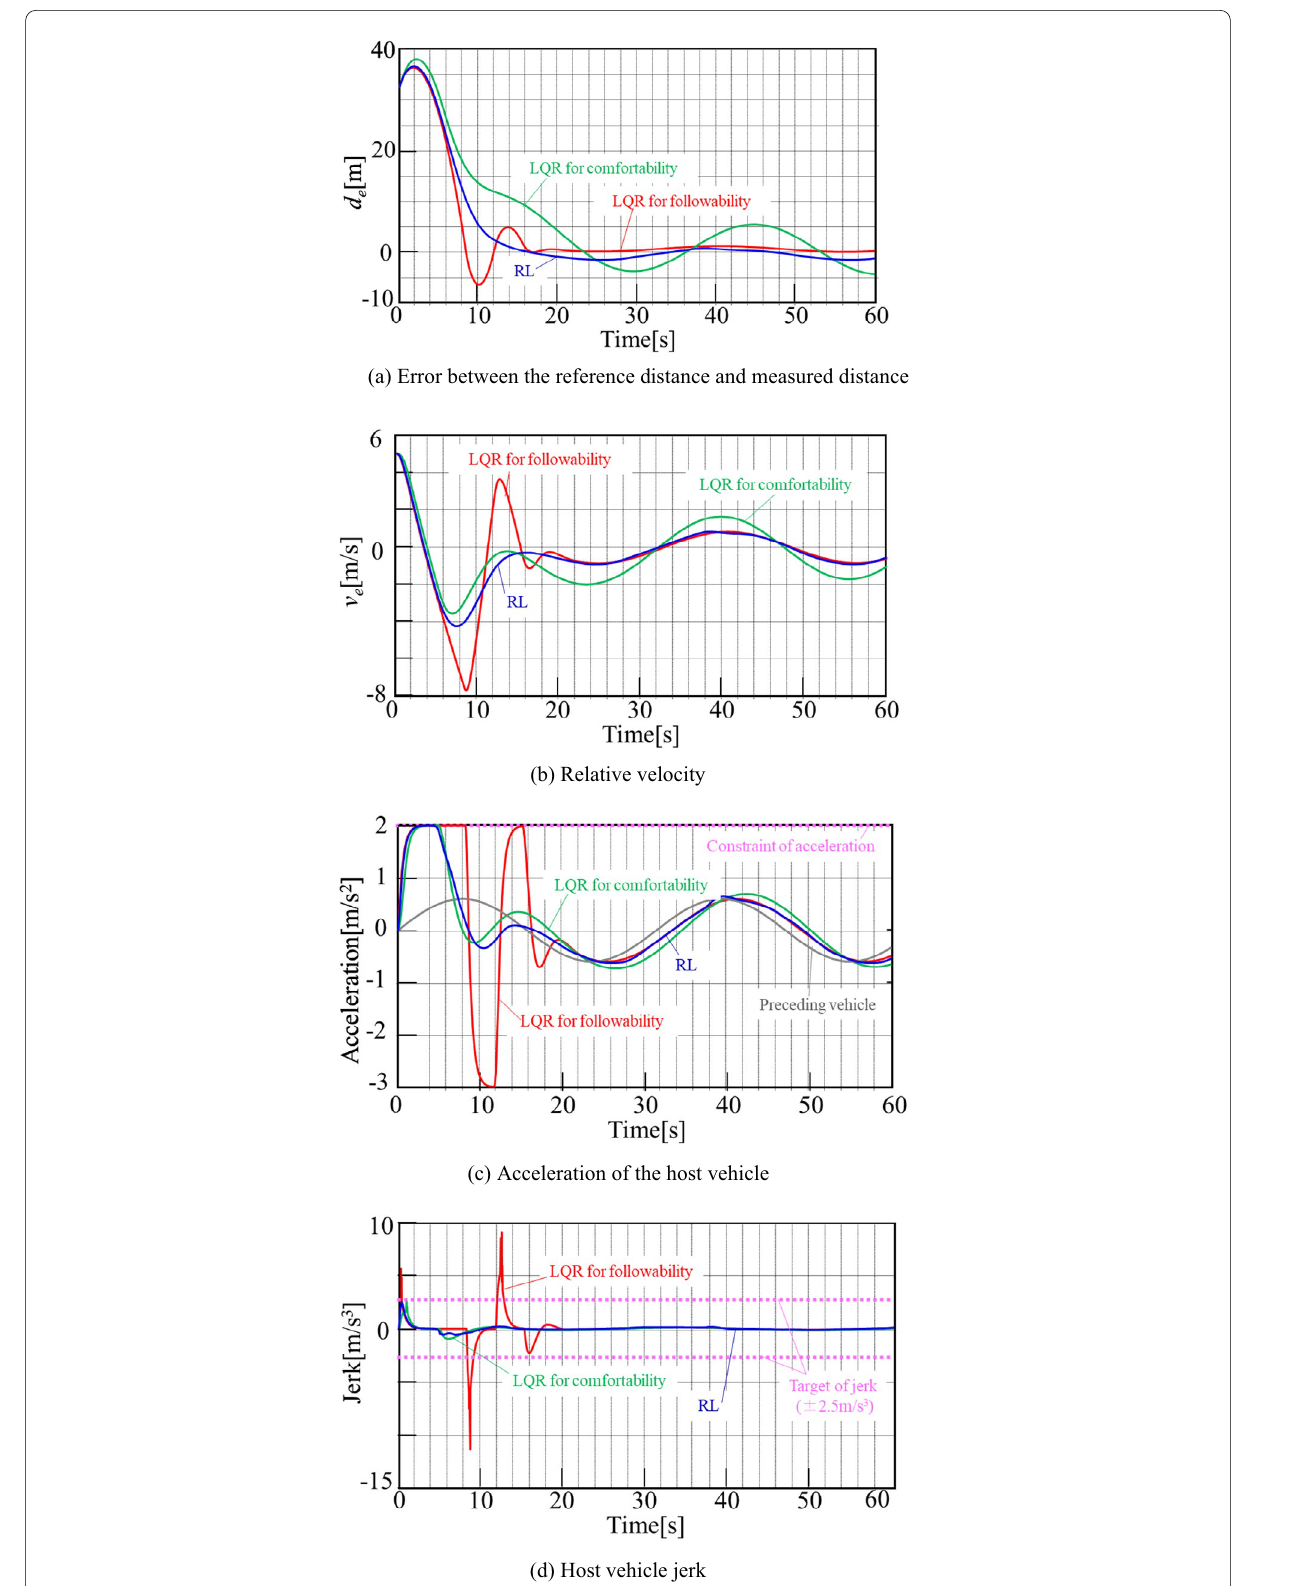
Fig. 4 (See legend on previous